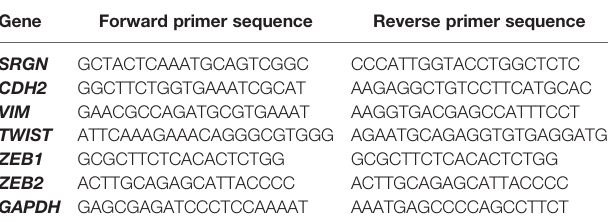
TABLE 1 | Primer list used for RT-qPCR. Gene Forward primer